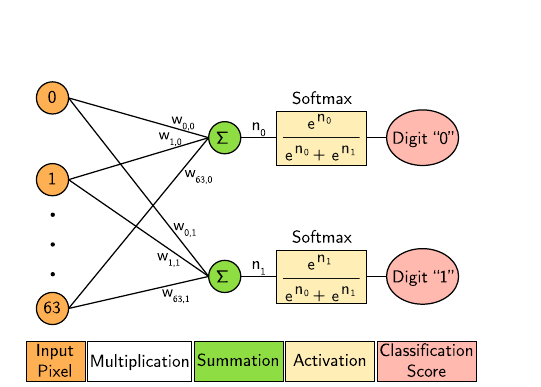
Fig.5|Networkarchitecture. Neuralnetworkfortheclassi fi cationof8×8images into the digits zero or one.